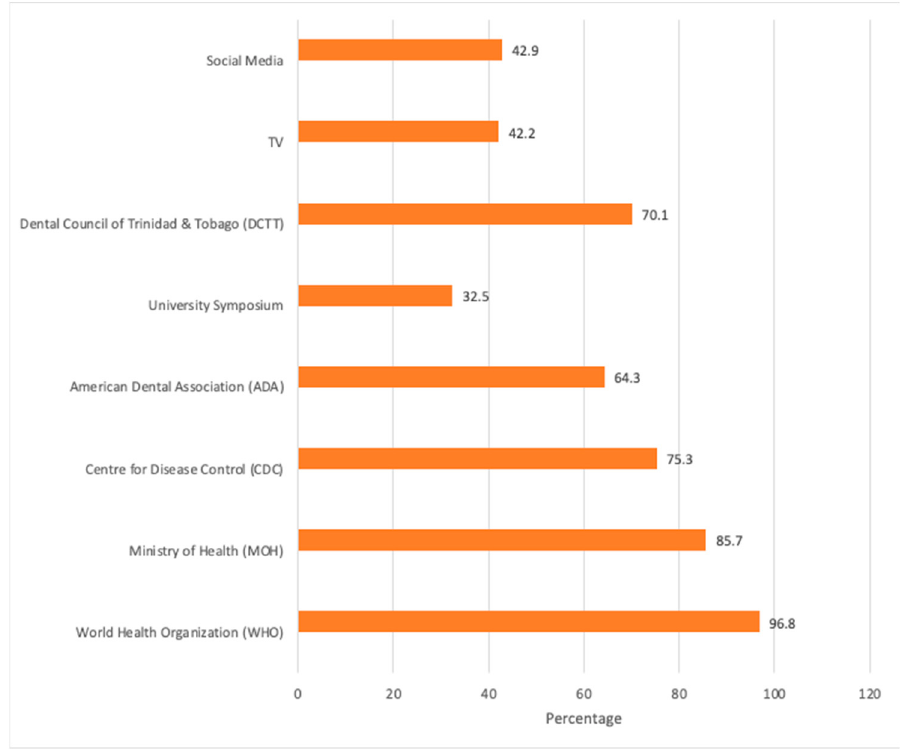
Figure 2. Sources of Information regarding COVID-19.